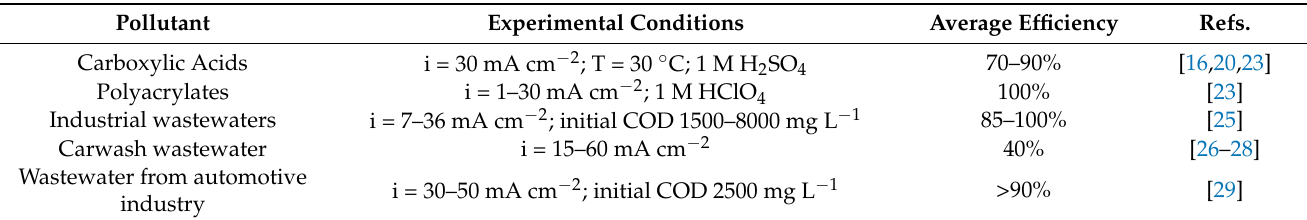
Table 1. Electrochemical oxidation of different organic substances using a BDD anode. Pollutant Experimental Conditions Average Efficiency